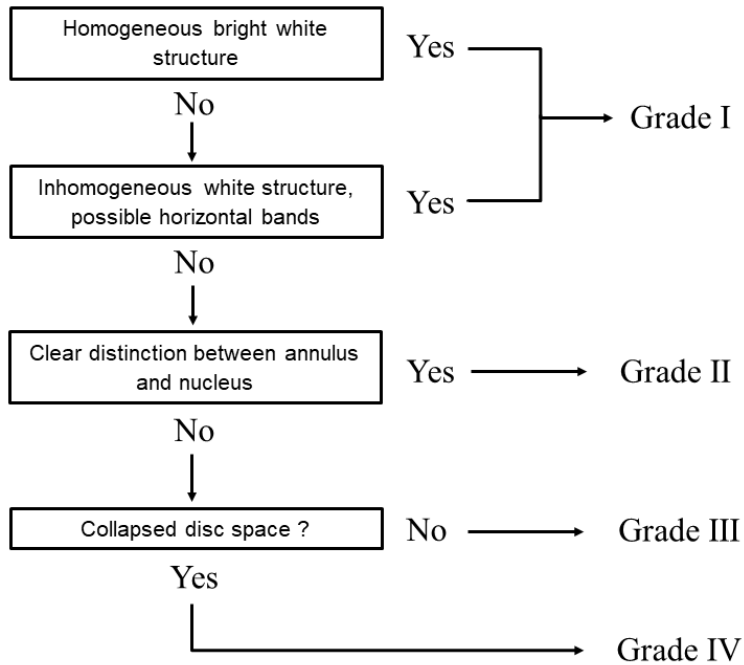
Figure 1. Algorithm for assessing the grade of cervical disc degeneration. The cervical disc degeneration grade is based on the modified Pfirrmann classification system.